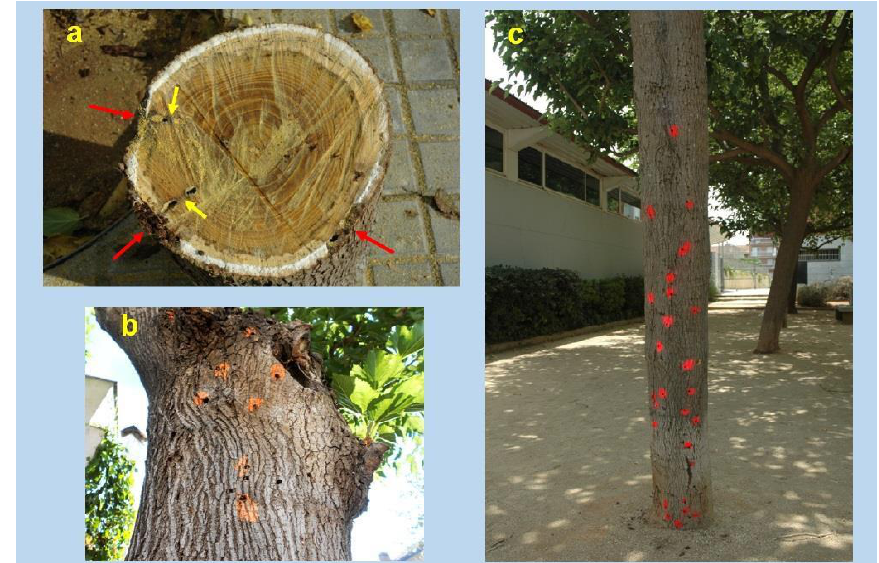
Figure 7. Same as in Figure 6. The sequential images here go from ( a – g ). (Photos Jordi Serra).